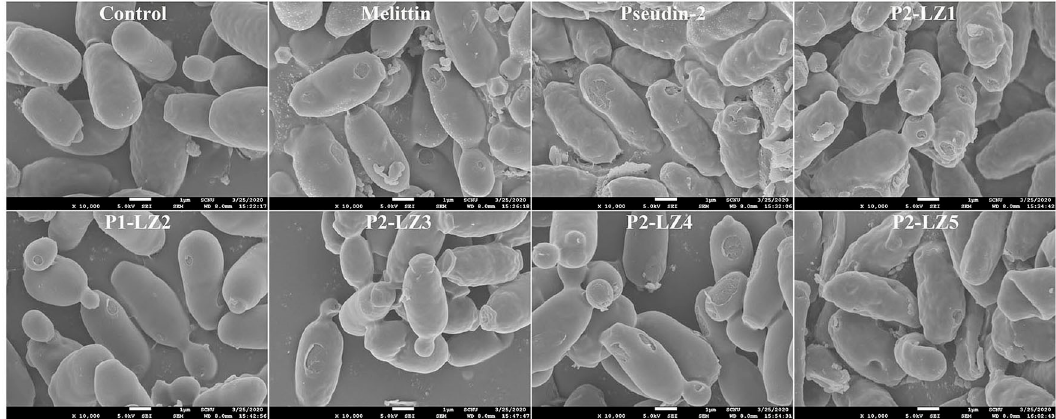
Figure 8. Morphological changes of C. tropicalis cells in the presence of pseudin-2 and P2-LZ peptides. Antibiotics 2020 , 9 , x FOR PEER REVIEW